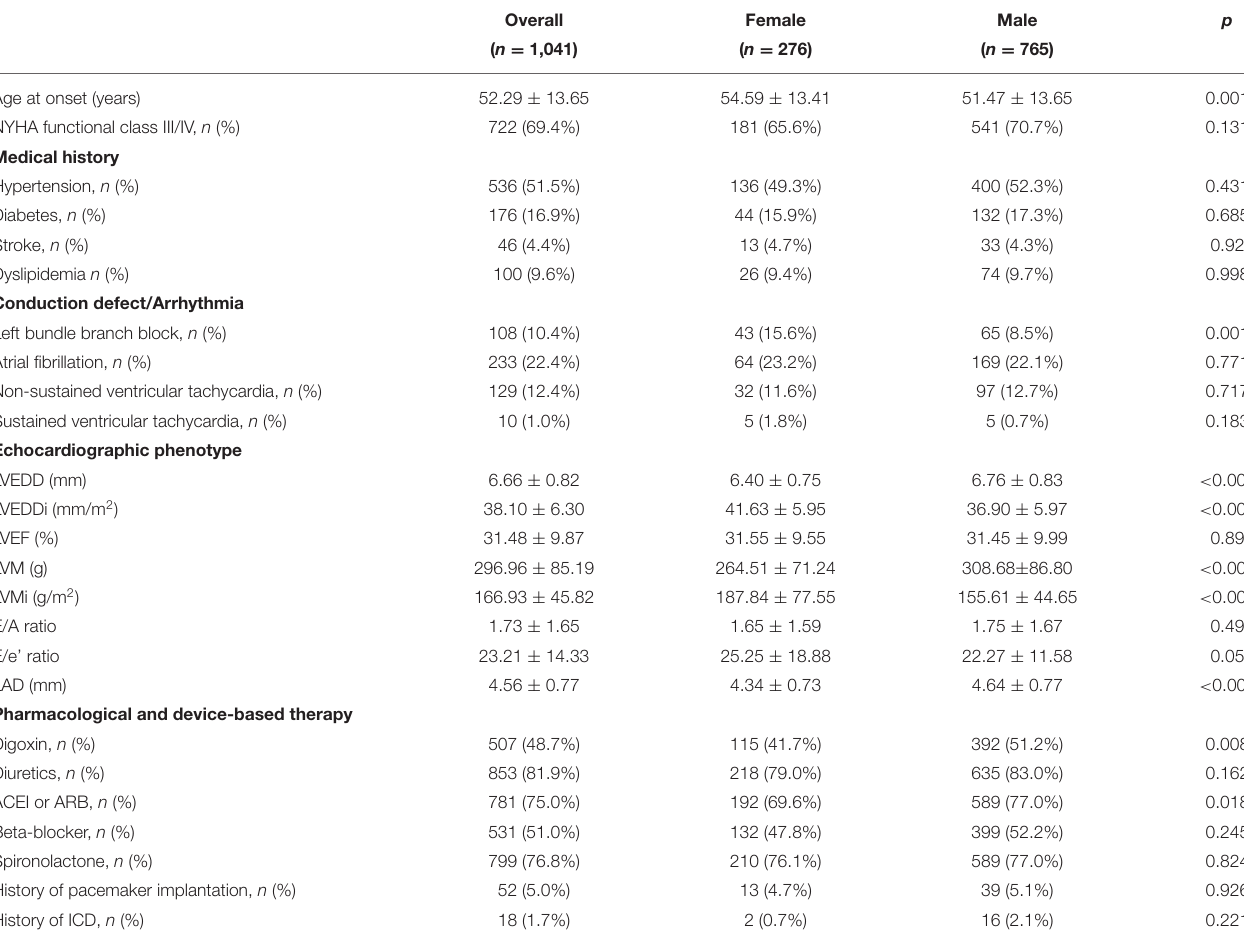
TABLE 1 | Baseline characteristics of DCM patients.